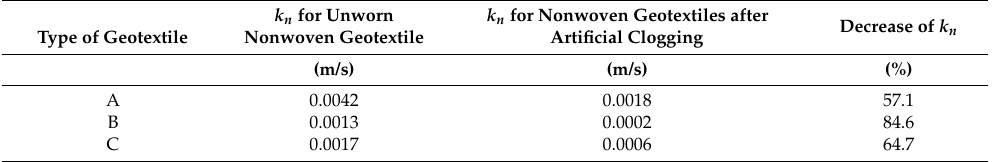
Figure 10. Nonwoven geotextiles before (top images) and after 120 min of artificial clogging (bottom images). Table 5. Coefficients of water permeability k n of the tested nonwoven geotextile samples.